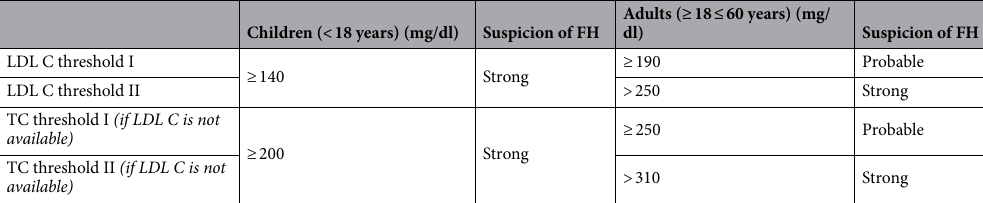
Table 1. Overview of defined thresholds triggering alert letters. Beside the thresholds, alert categories and associated severity levels are